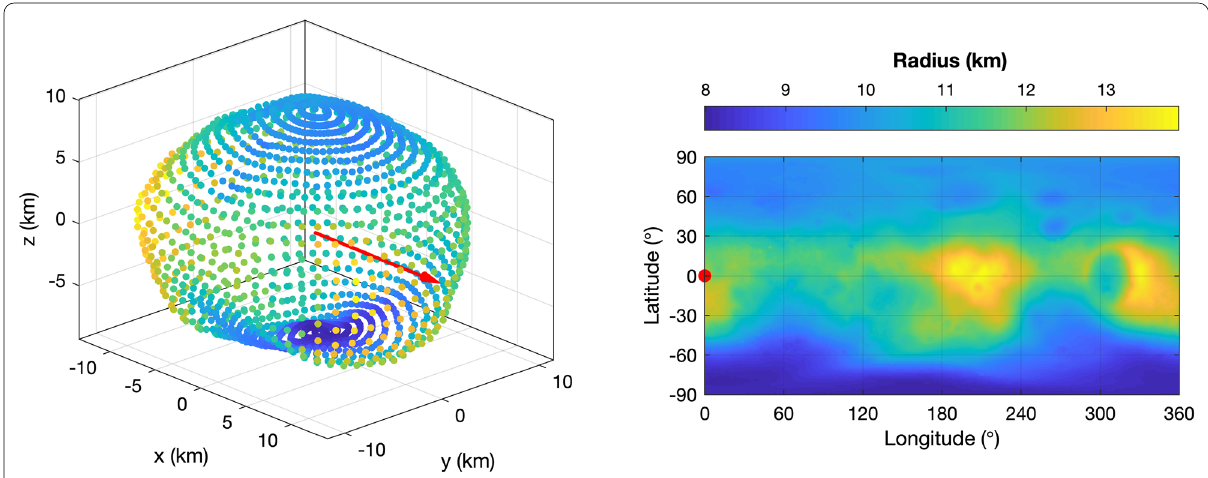
Fig. 3 Phobos DTM by Willner et al. (2014), as published at https:// pds‑ geosc iences. wustl. edu/ mex/ mex‑ msa‑ hrsc‑5‑ refdr‑ phobos‑ maps‑ v1/ mexhrs_ 5001/ data/ dtm/. Colour indicates the radius of Phobos as a function of location. The red arrow indicates the Mars‑facing vector, parallel with the positive x axis. Left – Points on a 6° x 6° lat,lon grid sampling the DTM, at which visibility metrics are evaluated in this study. Right – Plate carée projection of the DTM. The Mars‑facing vector, at lat 0°, lon 0° is marked by the red = =